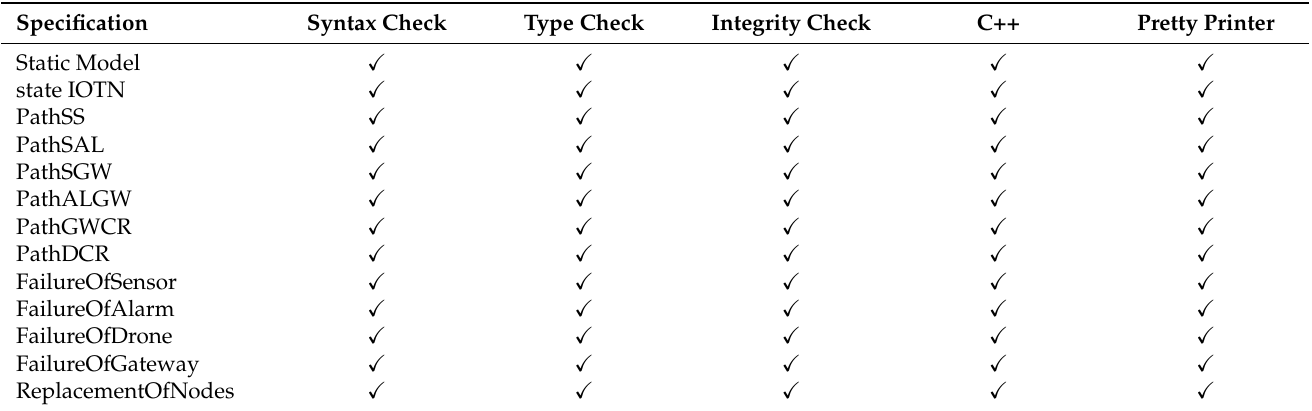
Table 3. Formal analysis results of failure detection and